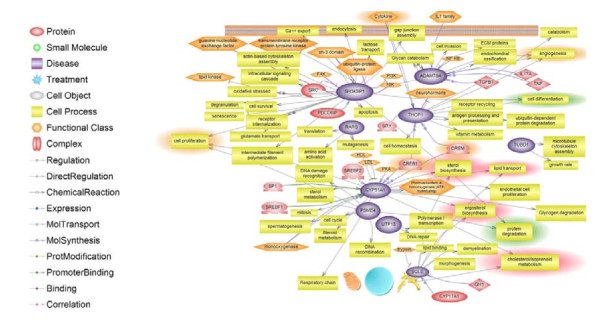
Pathway studio analysis of 21 differentially expressed genes. Out of 14 annotated genes, 9 genes were found to be involved in direct interactions. Five main pathway "hubs" (SH3KBP1, ADAMTS4, CYP51A THOP1 and SQLE) were detected in this pathway analysis. Each arrow indicates interactions between genes and a cell process pathway.